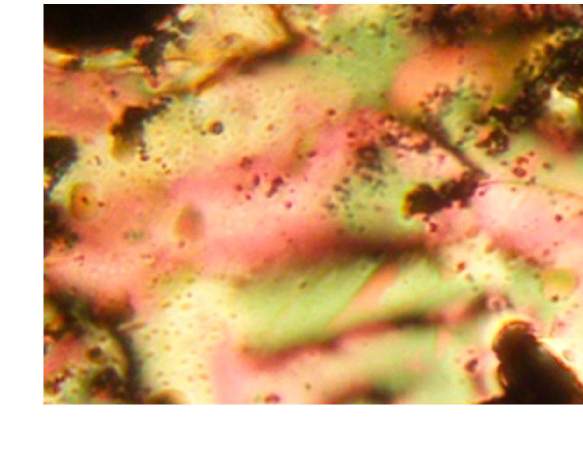
Figure 2. ( a ) A DSC thermogram (second scan) of B3-5 : scanning rate = 2 °C min −1 ; red line, heating; blue line, cooling. ( b ) A POM image of B3-5 , showing the N phase, observed at 140 °C.